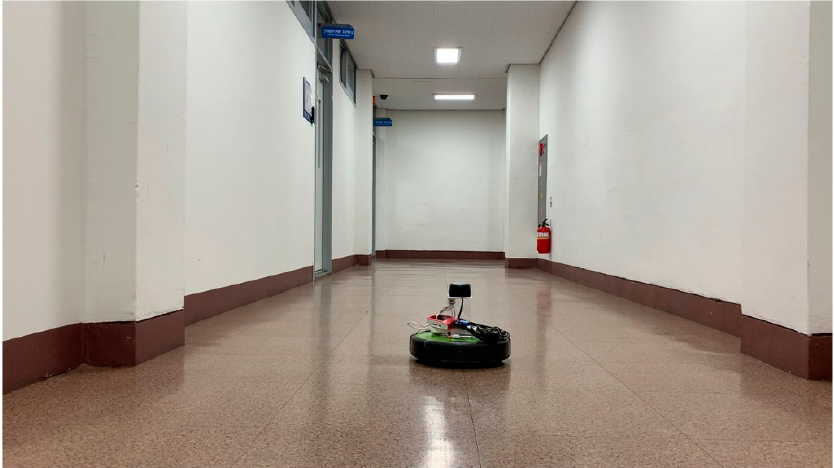
Figure 16. Initial position in indoor space where first autonomous scanning experiment was performed.